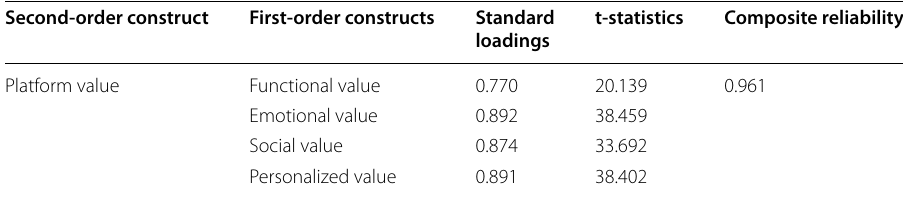
Table 5 Estimation of the second-order construct of platform